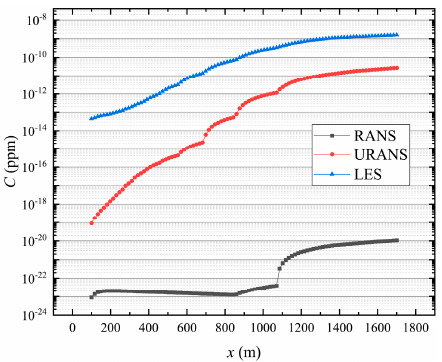
Figure 27. Comparisons of concentration at ground level.